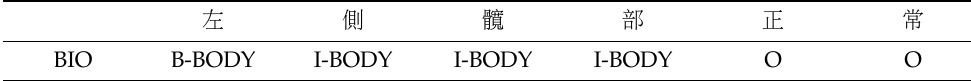
Table 1. An entity tagging example of “ 左側髖部正常 ”.